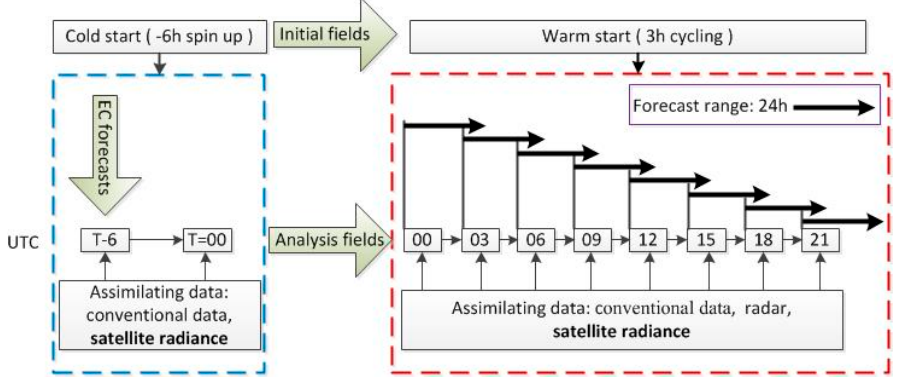
Figure 4. A schematic of the retrospective run with satellite radiance observations in RMAPS.